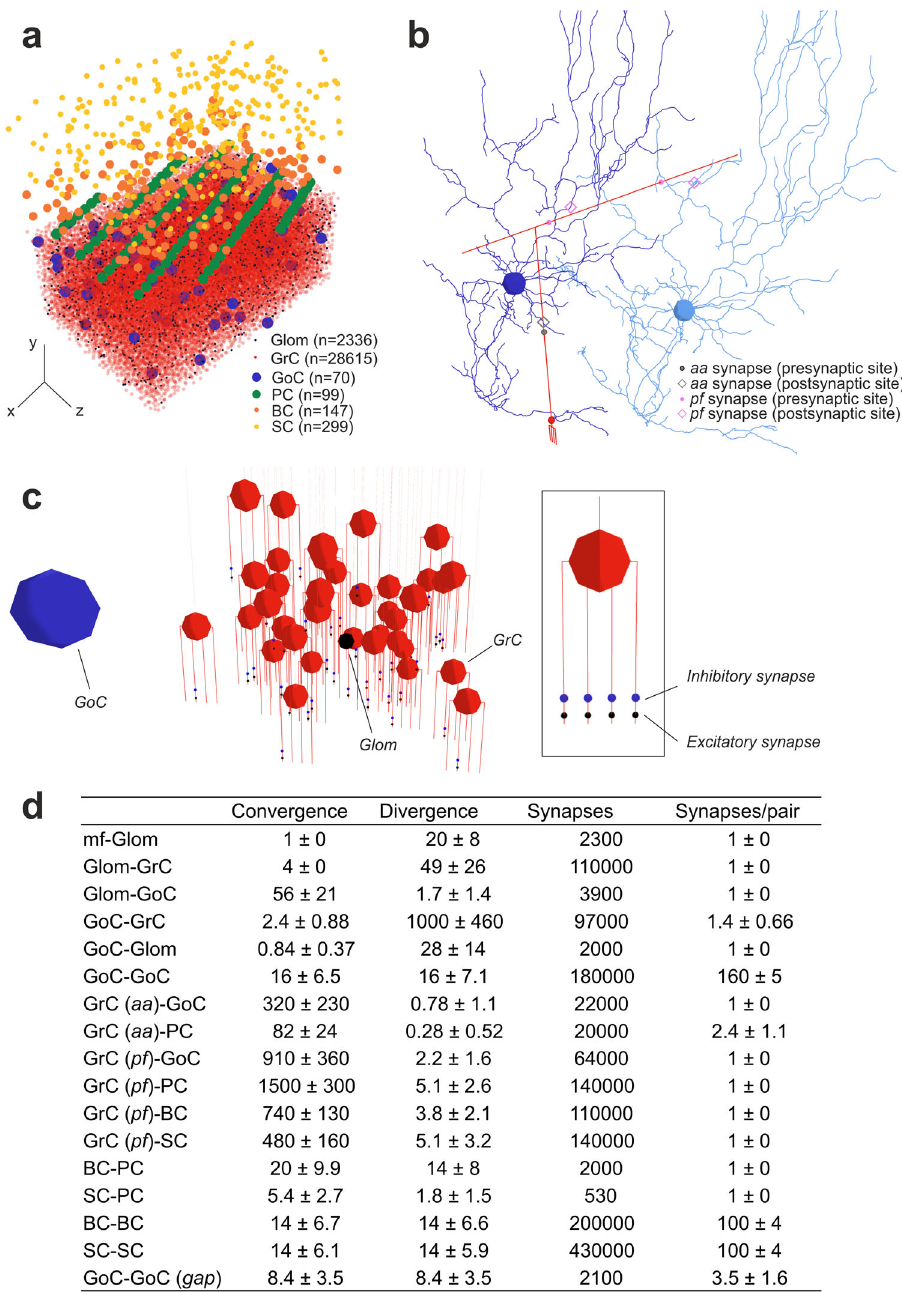
Fig. 2 Reconstruction of the microcircuit of cerebellar cortex. a Positioning of cell bodies in a 3D slab (300 × 295 x 200 μ m 3 ) of mouse cerebellar cortex. Cell numbers are indicated (the symbols re fl ect soma size). In this and the following fi gures, the xyz reference system is de fi ned by x-y (sagittal plane), x-z (horizontal plane), z-y (coronal plane), as in standard anatomical representation. Thus, y measures cortex thickness ( aa direction), while z identi fi es the major lamellar axis ( pf direction). b Example of 3D morphologies illustrating GrC - GoC connections through aa and pf . One GrC and two GoC s are shown: the synapse along aa is identi fi ed by touch detection , while synapses along pf are identi fi ed by fi ber intersection . c glom - GrC and GoC - GrC connections. A glom contacts a group of 38 GrCs forming an excitatory synapse on the terminal compartment of 1 of their 4 dendrites. The glom , in turn, is contacted by a GoC nearby, which forms an inhibitory synapse on the preterminal dendritic compartment of the same GrCs . The inset shows a GrC with 1 excitatory synapse and 1 inhibitory synapse on each dendrite. d The cerebellar cortical connectome generated by BSB reporting convergence (on the postsynaptic element), divergence (from the presynaptic element), total number of synapses, and number of synapses for each connected pair. It should be noted that mf-glom is not a proper synapse but just a Cerebellar network simulations . Network simulations were car- resolution. All simulations were carried out in the presence of ried out using detailed neuronal and synaptic models written in NEURON for GrC 17 , GoC 16 , PC 18,20 , SC and BC 19 . Local micro- circuit responses to input patterns were tracked back to individual neurons and used to follow signal propagation with unprecedented